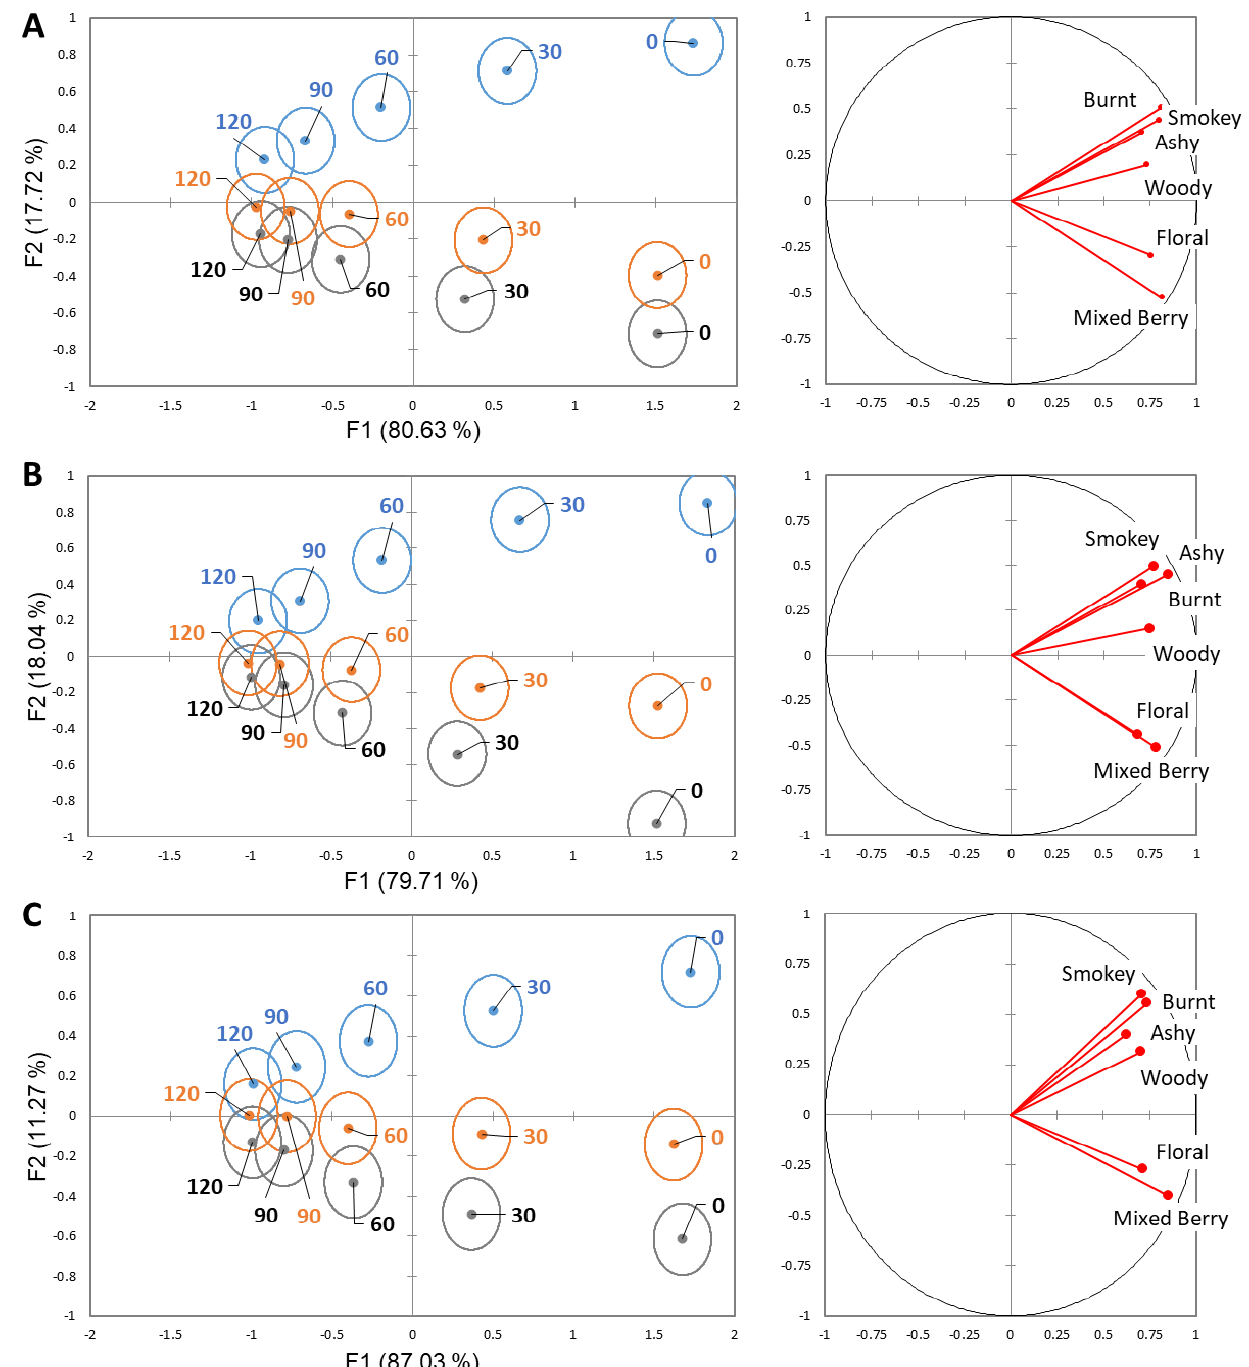
Figure 2. Separation of high smoke phenol (blue), moderate smoke phenol (orange), and low smoke phenol (grey) wines in 30 s intervals based on DA for each rinse system: ( A ) water, ( B ) pectin, and ( C ) mouthwash. Ellipses represent a 95% confidence interval, around the means.